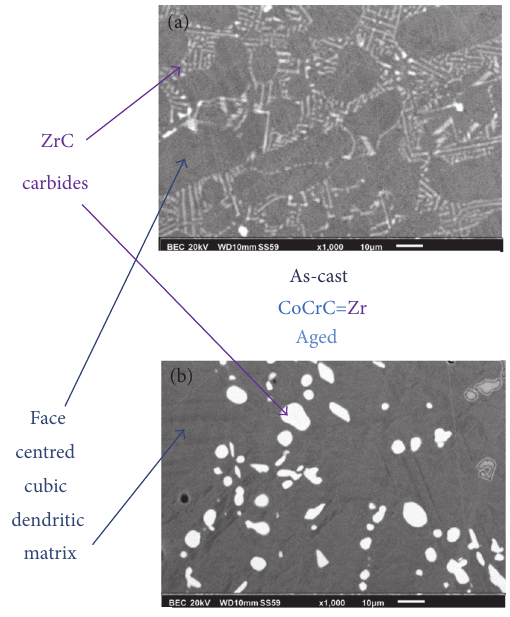
Figure 7: The as-cast (a) and aged (b) microstructure of the “CoCrC=Zr” alloy (SEM/BSE